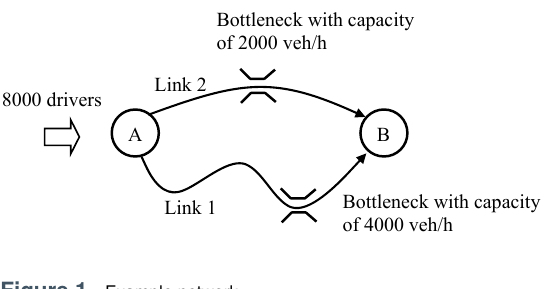
Figure 1. Example network.